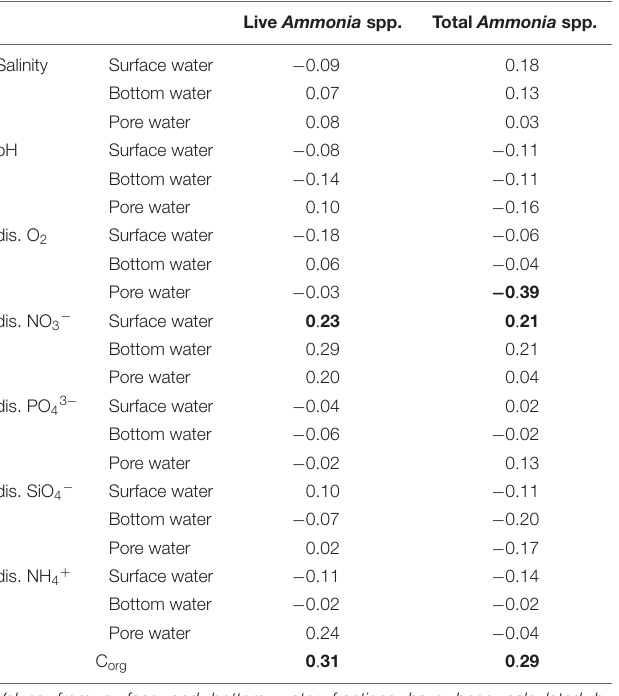
TABLE 4 | Values of Pearson’s correlation co-efficient between observed number of Ammonia specimens and the studied parameters. Live Ammonia spp. Total Ammonia spp.